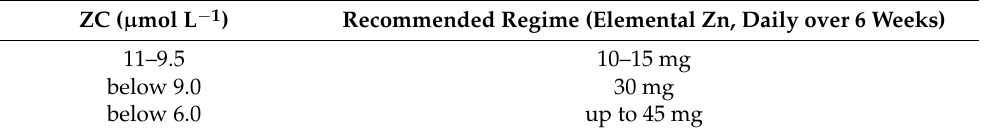
Table 1. Recommended dosages of zinc supplements for different degrees of zinc deficiency con- firmed by decreased serum zinc concentration